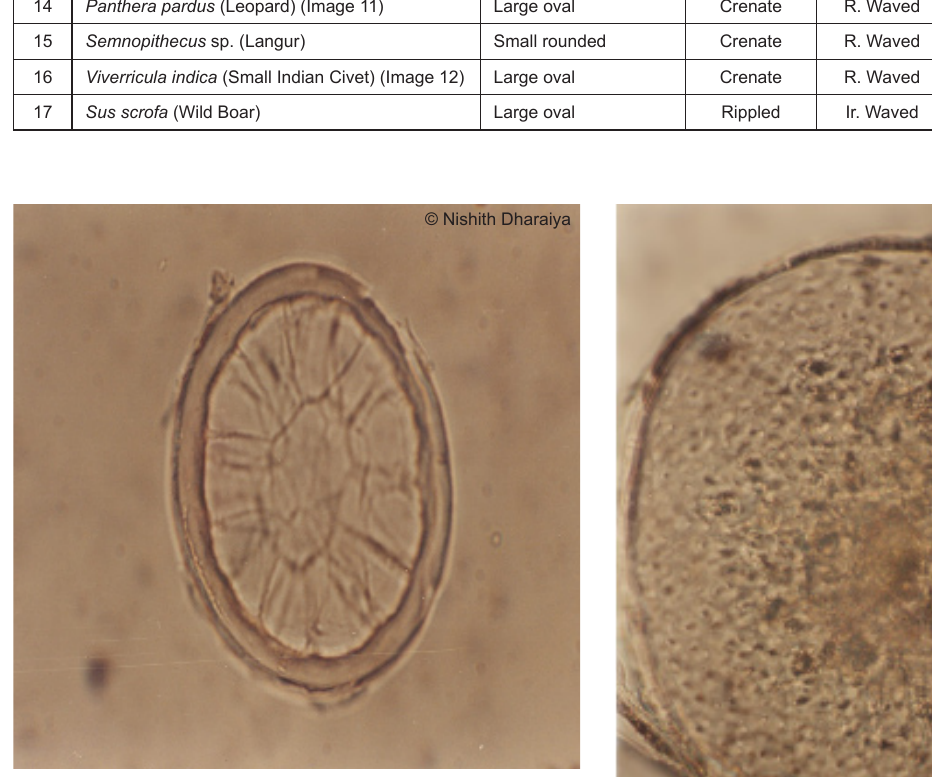
Image 1. Cross section of hair of Chital